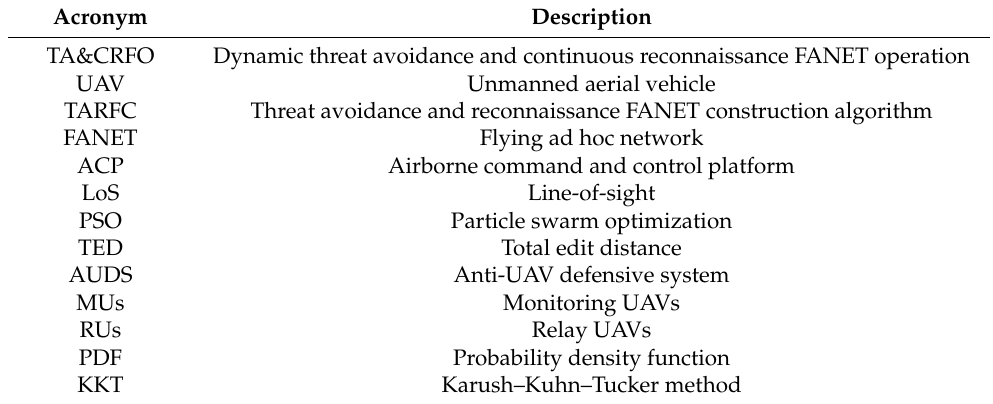
Table 1. List of acronyms.